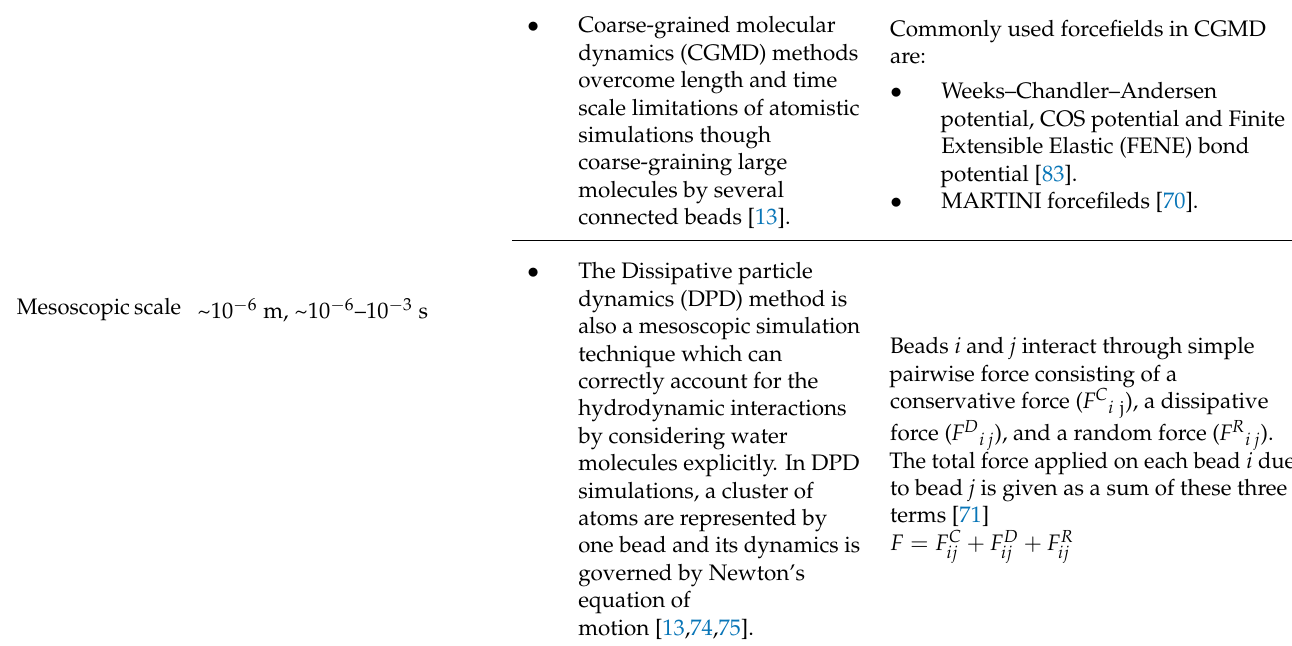
Scales Length and Time Scales